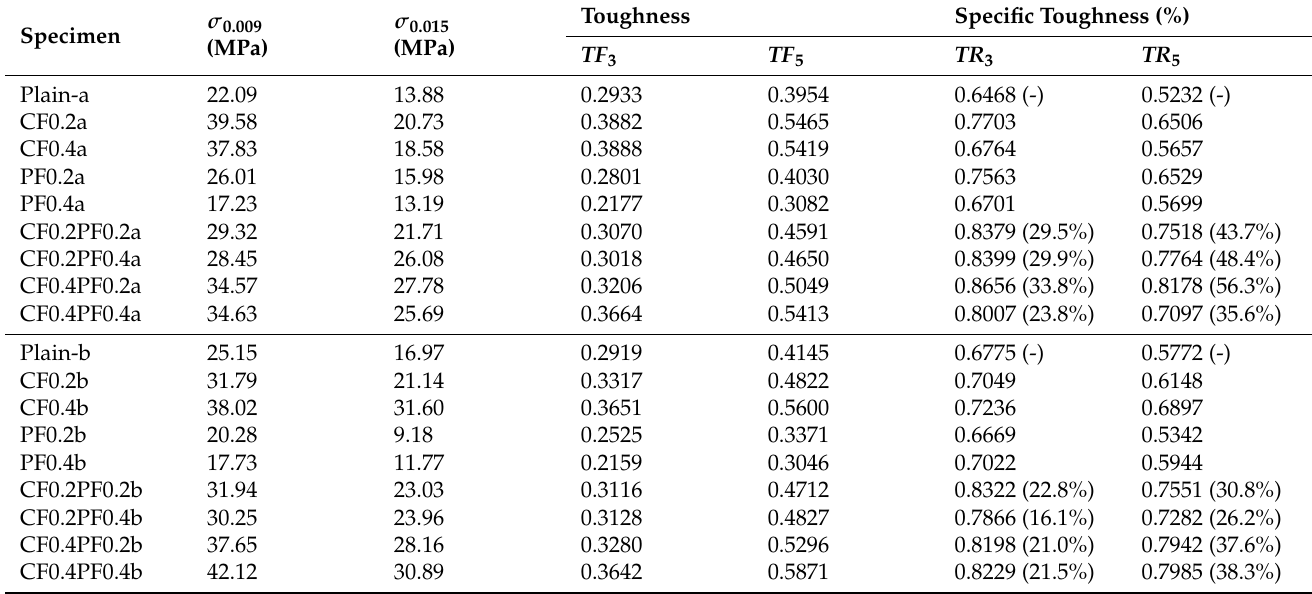
Table 6. Toughness and specific toughness of